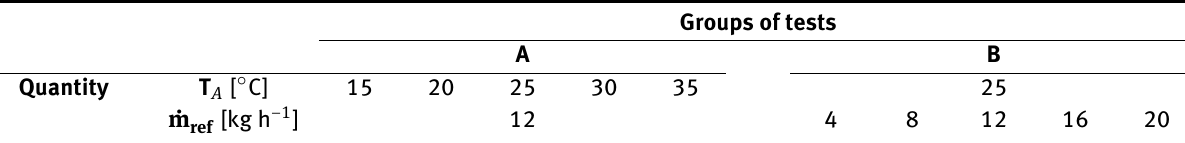
Table 4: Summary table with the tests carried out in the experimental study.